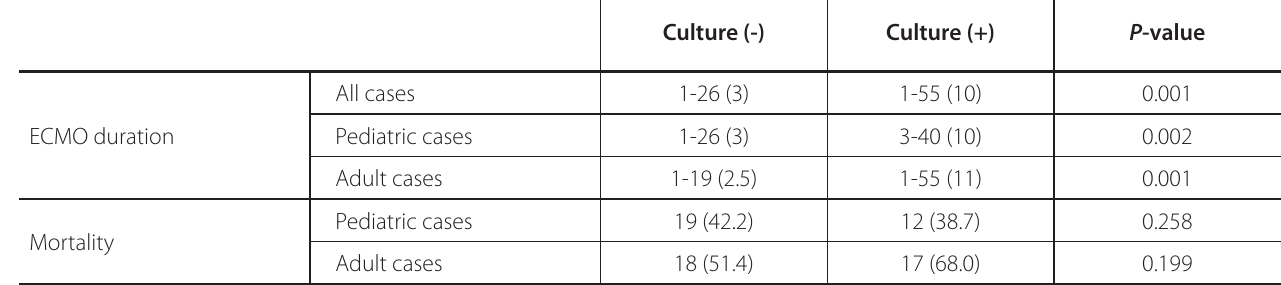
Table 5 . ECMO durations and culture